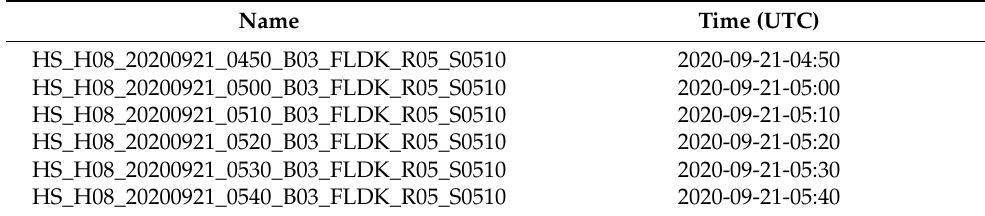
Figure 2. Himawari-8 visible band full disk image of the Celebes Sea on 20 September 2020 at 05:20 UTC. Four solitons occur in the image that propagate toward the coast of Indonesia. Details of the Himawari-8 images applied in this paper are presented in Table 1. Table 1. Basic information of the 6 Himawari-8